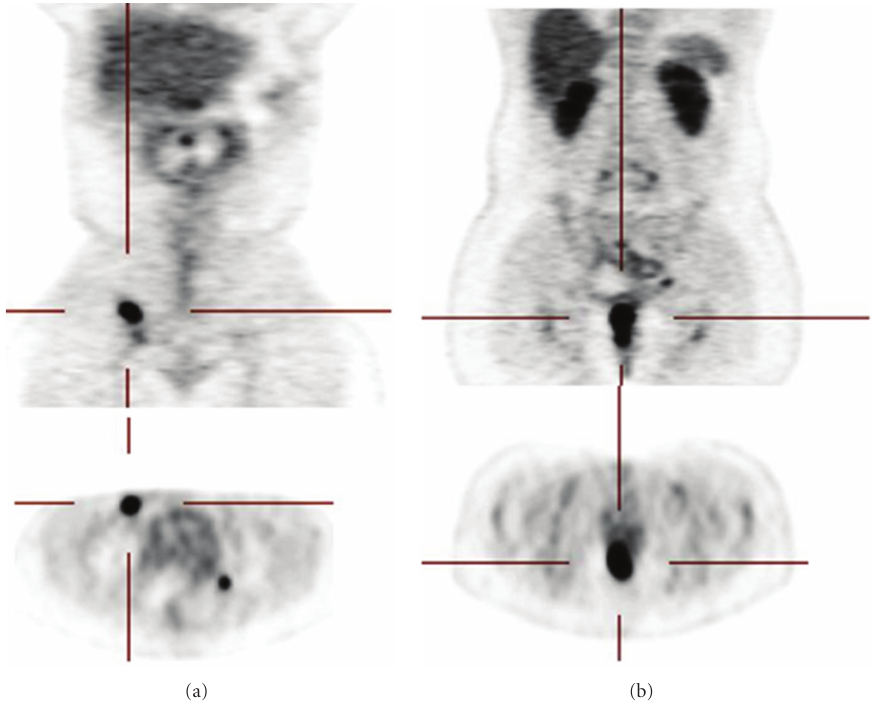
Figure 2: PET scan showing uptake in right inguinal region (a) and anal canal (b). gross anal tumor and the right inguinal region and 47 Gy in 27 fractions to the pelvis. Intensity-modulated radiation therapy was